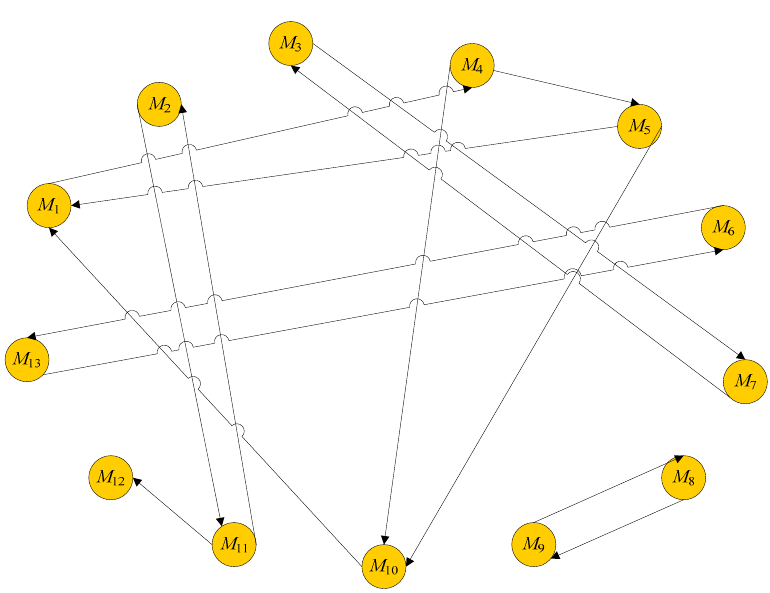
Figure 4. Failure correlation graph of the target CNC machine tool.